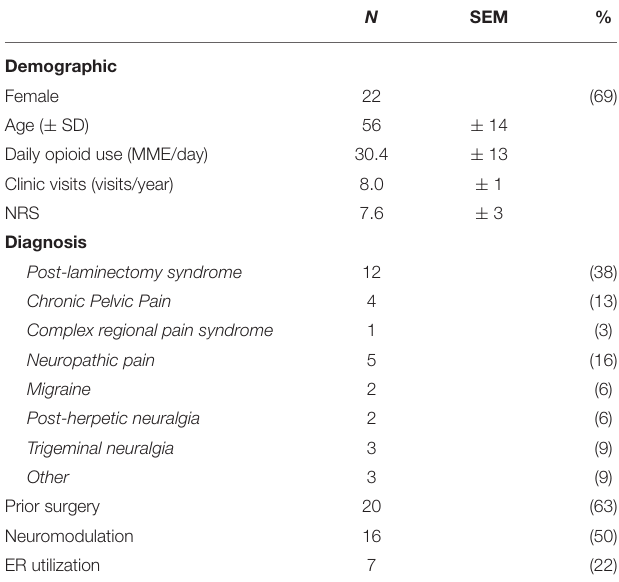
TABLE 1 | Pre-inclusion patient demographics and clinical